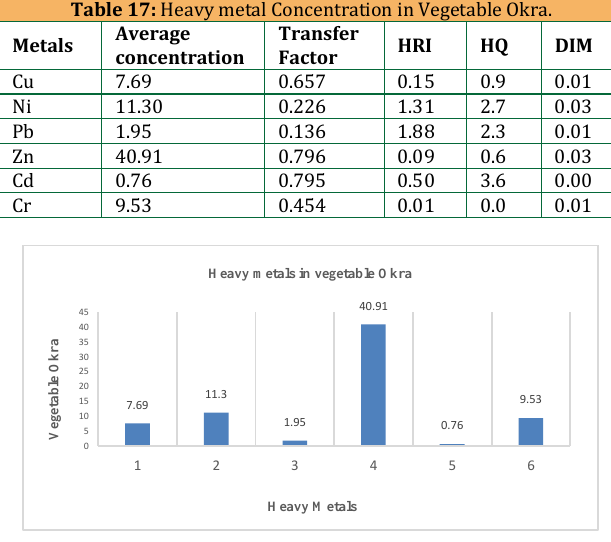
Figure 14: Average Concentration in vegetable Okra